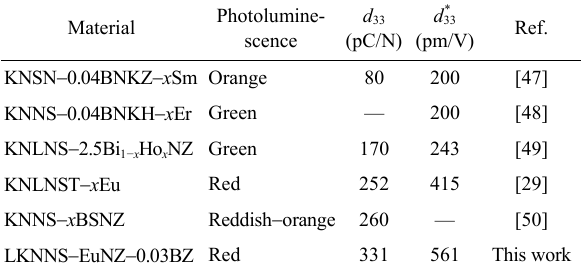
Table 2 Piezoelectric properties reported recently in the representative fluorescent KNN-based lead-free ceramics Photolumine- Material